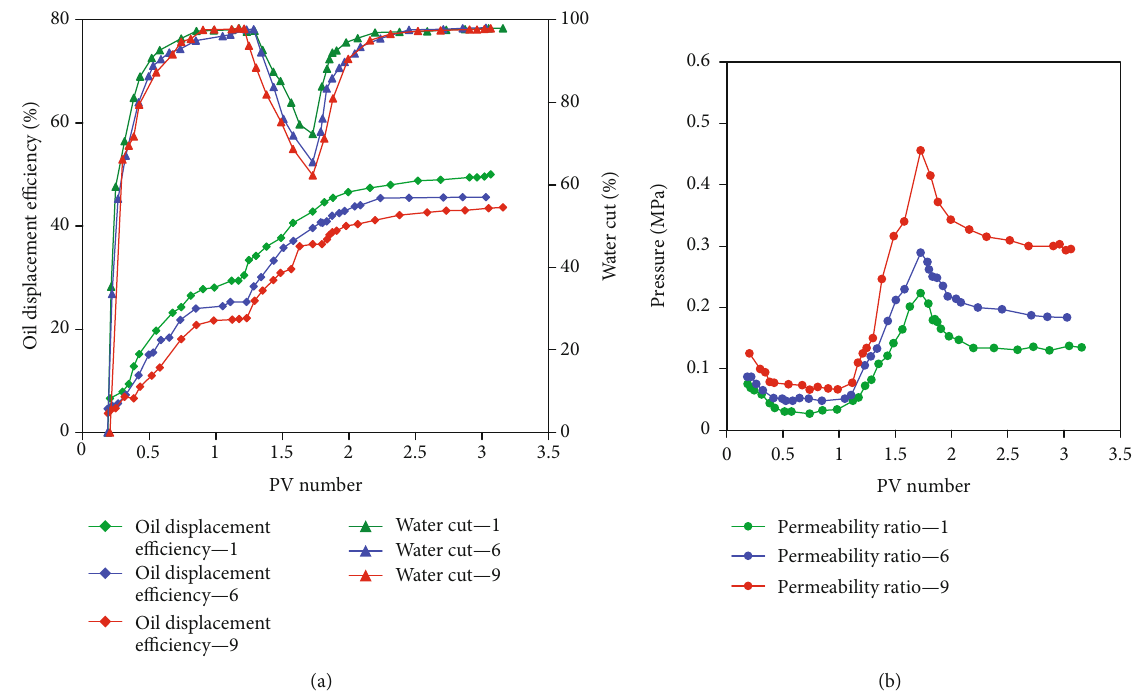
Figure 11: Curves of injection pore volume versus oil displacement e ffi ciency under di ff erent permeability ratios for the polymeric surfactant: (a) oil displacement e ffi ciency and water cut; (b) pressure.